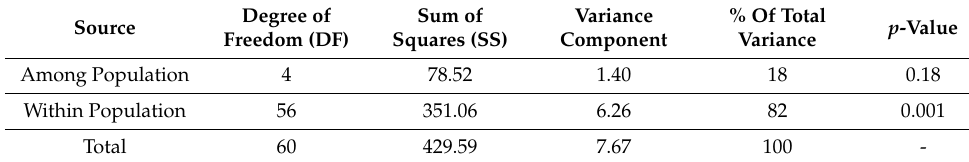
Table 4. AMOVA of forage pea ( P. sativum ssp. arvense L.) landrace accessions.